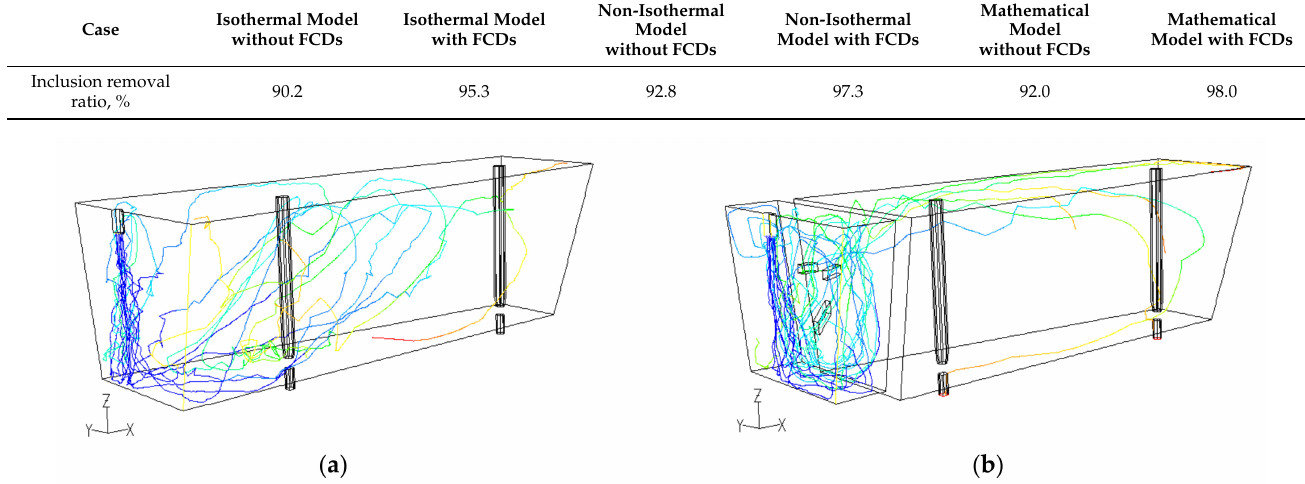
Figure 8. Inclusion trajectories according to the numerical simulation. ( a ) Without FCDs; ( b ) with optimized